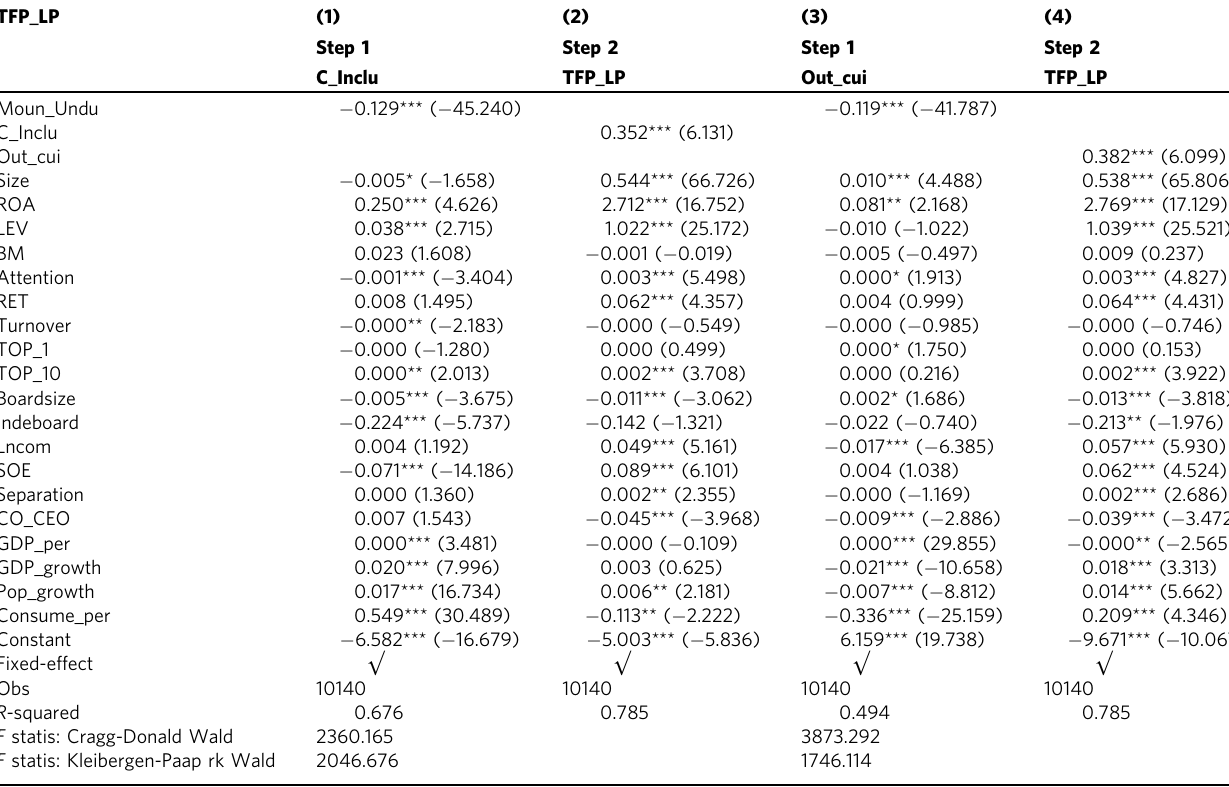
Table 4 The impact of cultural inclusion on corporate sustainability: instrumental variable